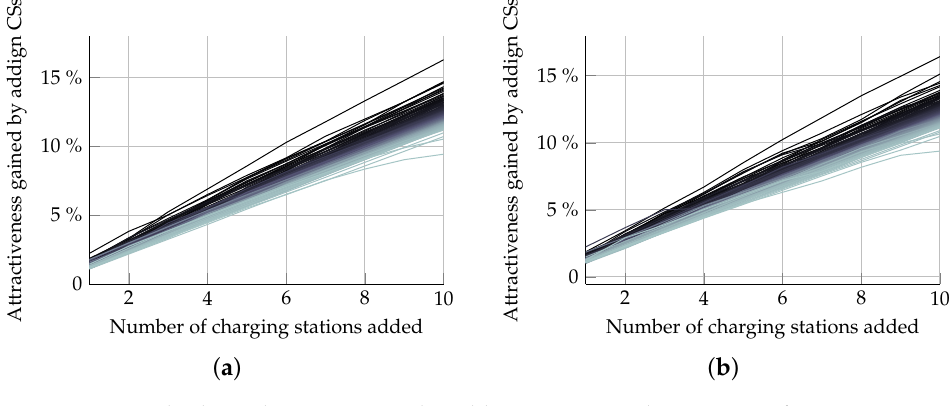
Figure 7. Increased achieved attractiveness by adding new CS to the existing infrastructure using the optimization strategy cooperating ( a ) and competing ( b ). Each line shows the result for a single district, with the color becoming darker for districts with greater improvements. Example of how to read: In the cooperating case, after adding 10 CS the highest covered attractiveness was